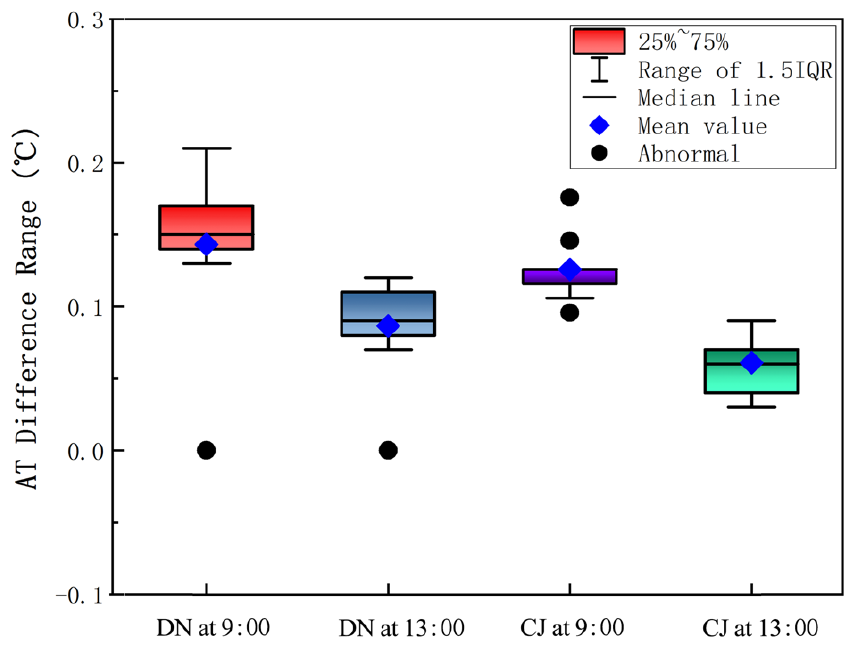
Figure 6. Box plot of air-temperature difference between W-E road and S-N road at 1.5 m from the ground at 9:00 (morning) and 13:00 (afternoon) on 21 July 2018. Table 6. Model